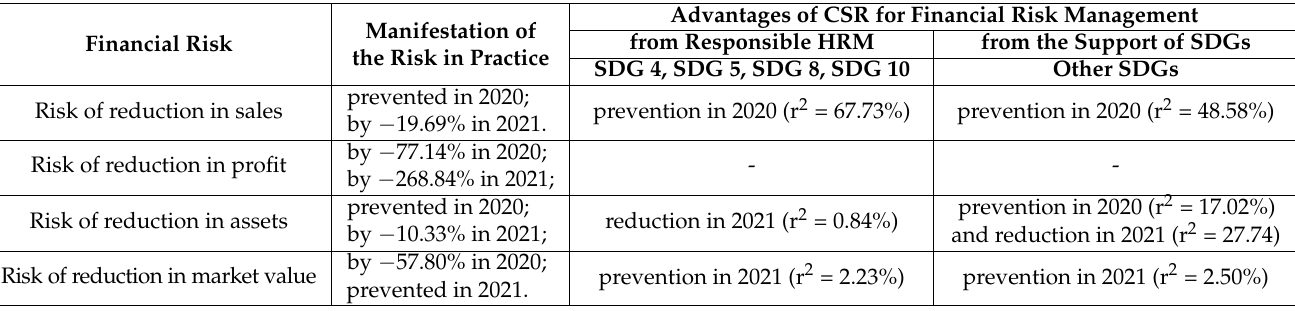
Table 6. The systematisation of CSR practices for sustainable development and their advantages for financial risk